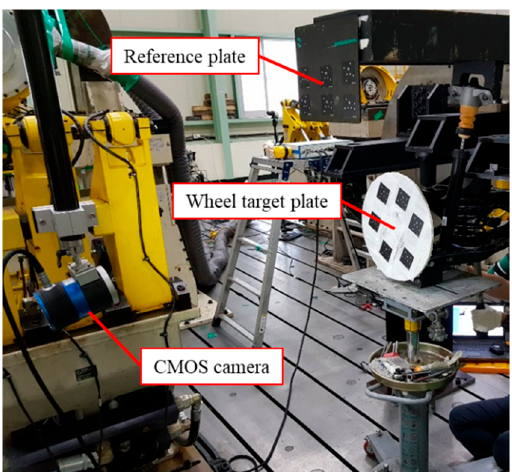
Figure 12. Verification system for wheel alignment inspection.